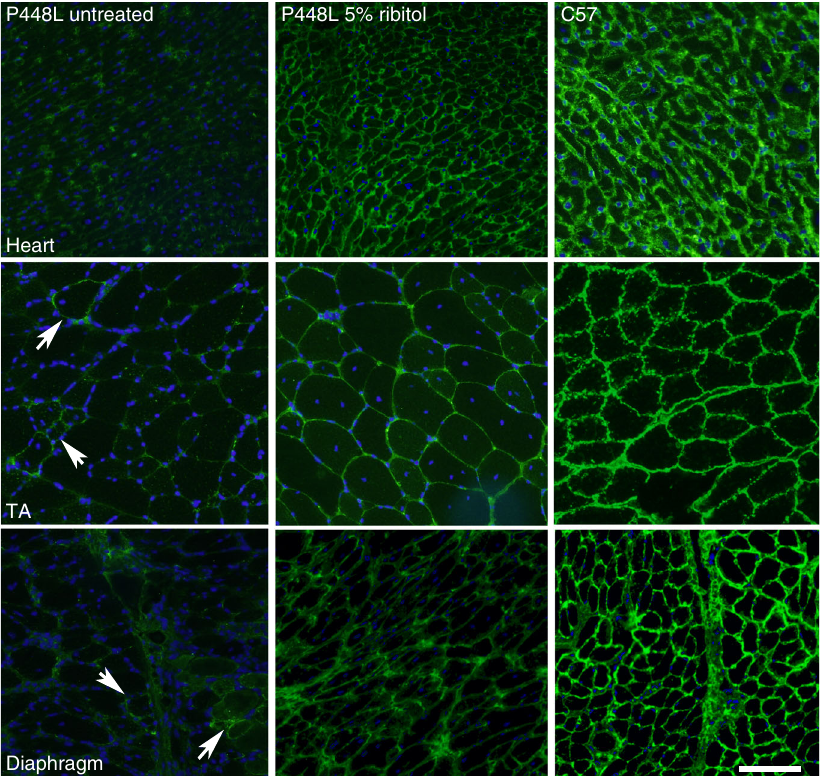
Fig. 1 Induction of F- α -DG in cardiac and skeletal muscles in P448L mutant mouse treated with ribitol for 1 month. Four-week-old P448L mice were given drinking water only ( n = 4), or drinking water supplemented with 5% ribitol ( n = 4) for 1 month. Immunohistochemical staining with IIH6C4 antibody of cardiac (heart), tibialis anterior (TA), and diaphragm muscles from the untreated and 5% ribitol-treated P448L mice (left and middle panel, respectively), and C57BL/6 control (C57, right panel). Arrows indicate the revertant fi bers expressing detectable F- α -DG. Scale bar, 50 μ m. Cellular nuclei were counterstained with DAPI